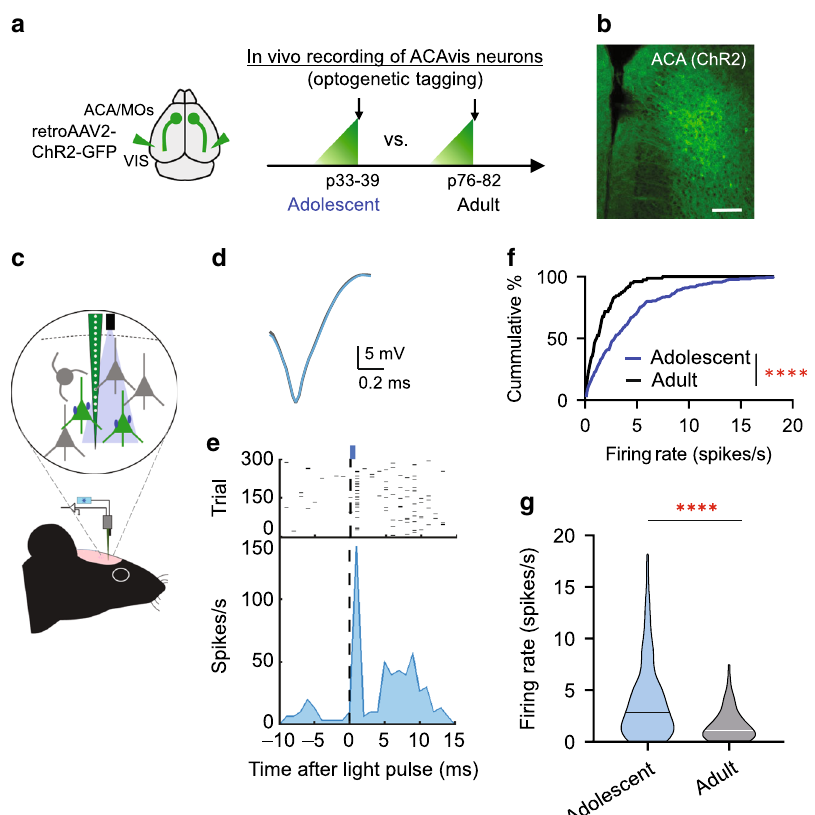
Fig. 4 Greater fi ring activity of adolescent ACAvis neurons in vivo. a Schematic of viral approach to express Channelrhodopsin-2 (ChR2) in frontal